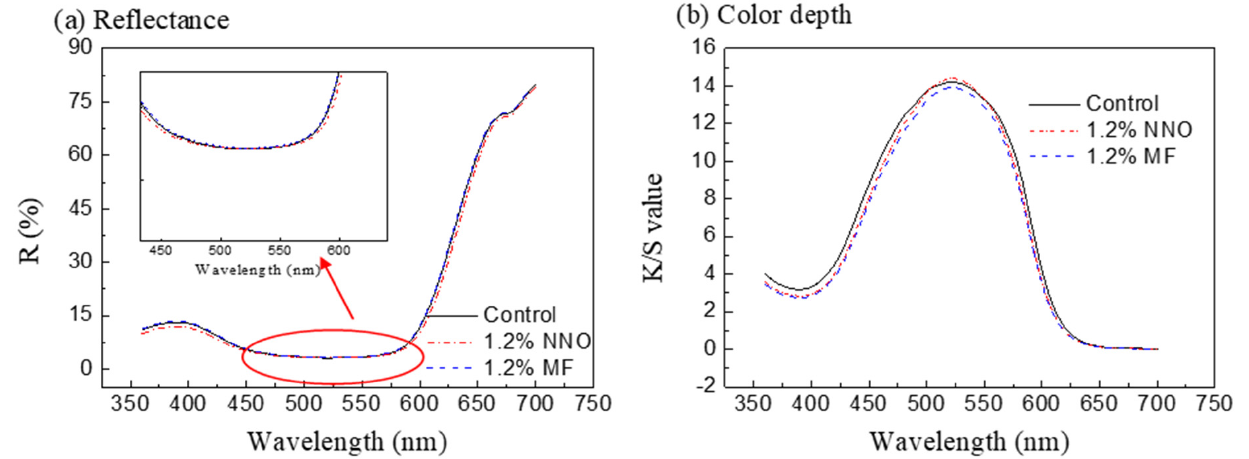
Figure 4. Influence of dispersant on the reflectance ( a ) and the color depth ( b ) of the dyed fabric. From the results of Figure 4b, the maximum absorption wavelength of disperse red 177 was at 520 nm when there was no dispersant during dyeing. When dispersant NNO and MF were used in the silicone waterless dyeing system, the maximum absorption wavelength of disperse red 177 did not change. For the color depth, the K/S value of the dyed fabric increased from 14.26 to 14.73 when 1.2% o.w.f of NNO was